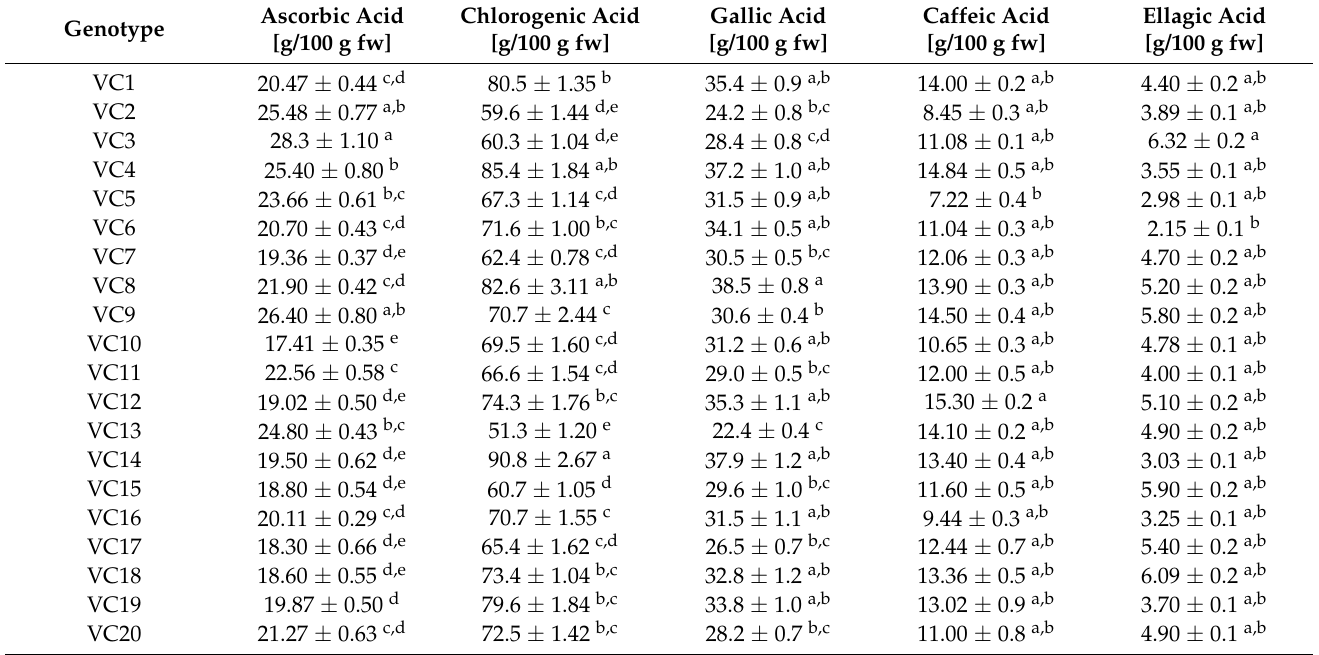
Table 2. Content of ascorbic and phenolic acids in fruits of M. nigra